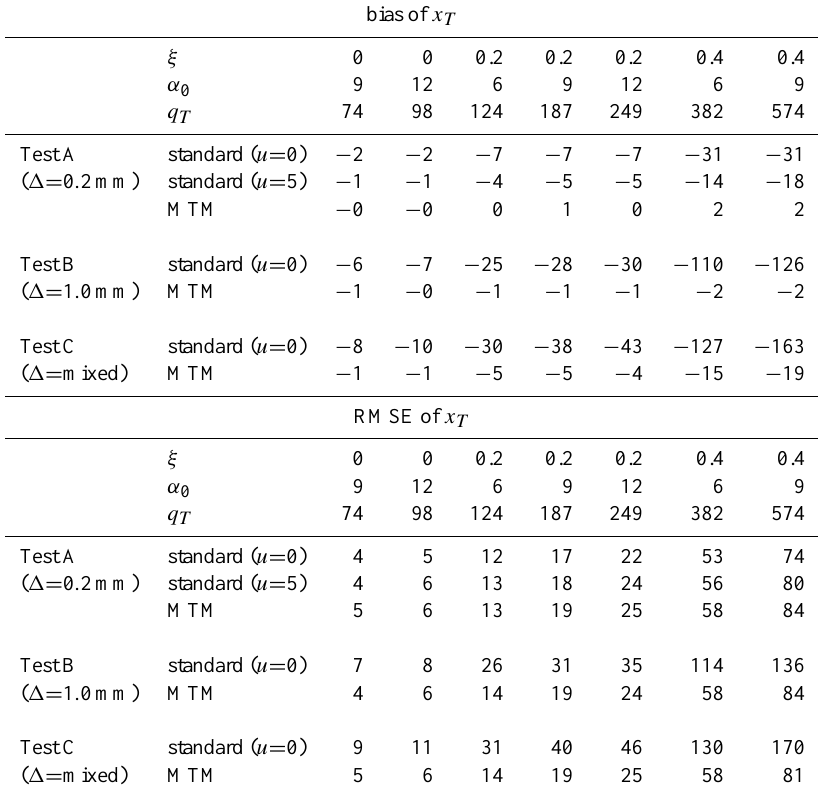
Table 4. Same as Table 1 but for x 50 extreme quantile estimates corresponding to a 50-yr return